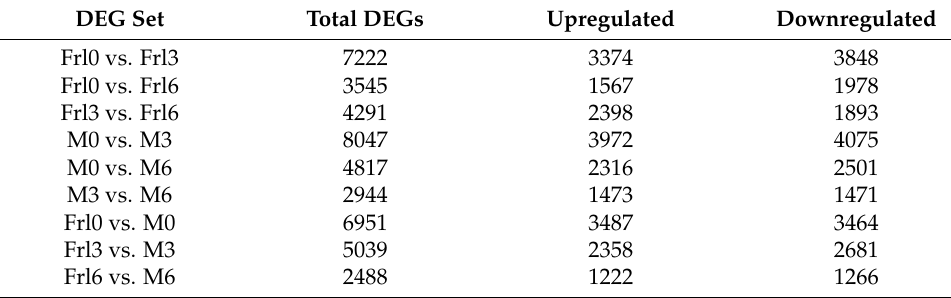
Table 1. Statistics for DEGs exhibiting different expression patterns. DEG Set Total DEGs Upregulated